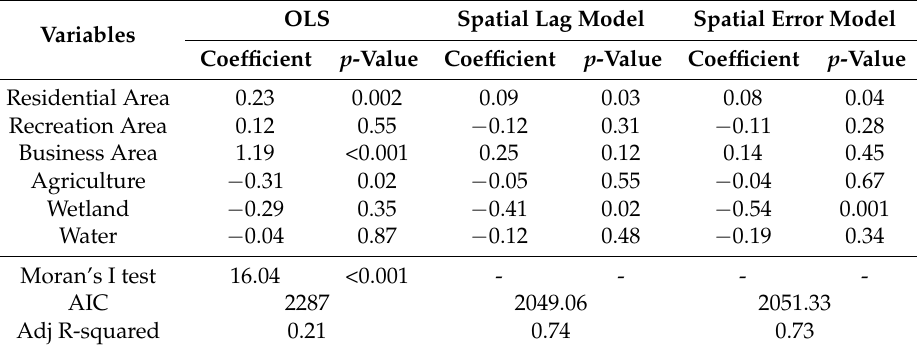
Table 1. Spatial regression analysis of DF and LCLU types in the metropolitan region of Tainan City, 2015.